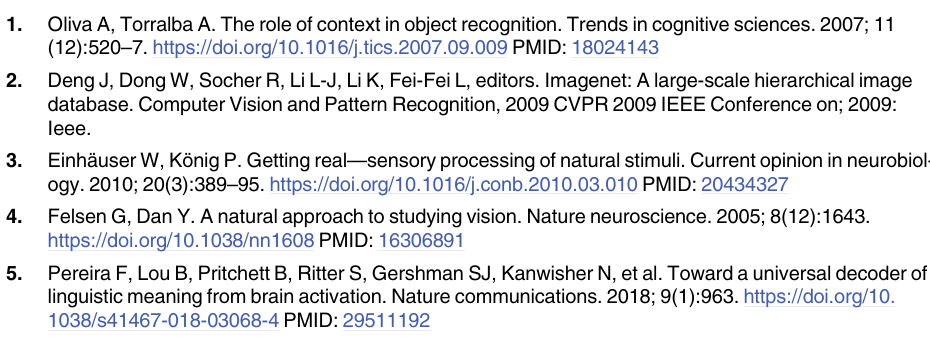
S1 Table. List of all 1,854 object